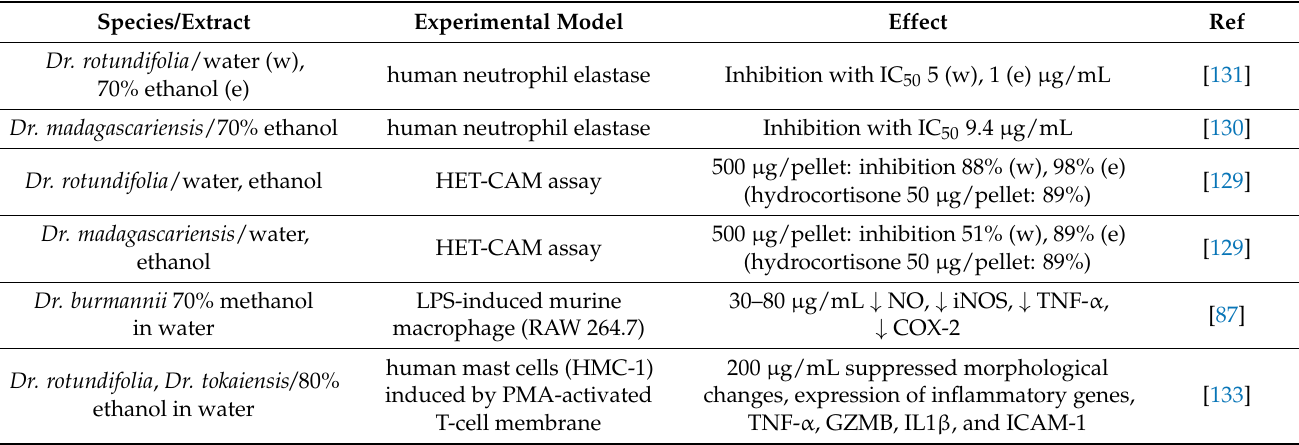
Table 5. Anti-inflammatory activity of Droseraceae and Nepenthaceae